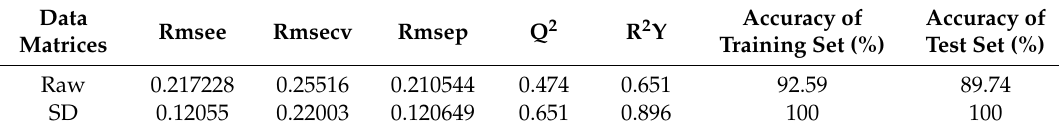
Table 3 . Summary of the classification of Lingzhi by different models and spectra pretreatment using ATR-FTIR spectra.